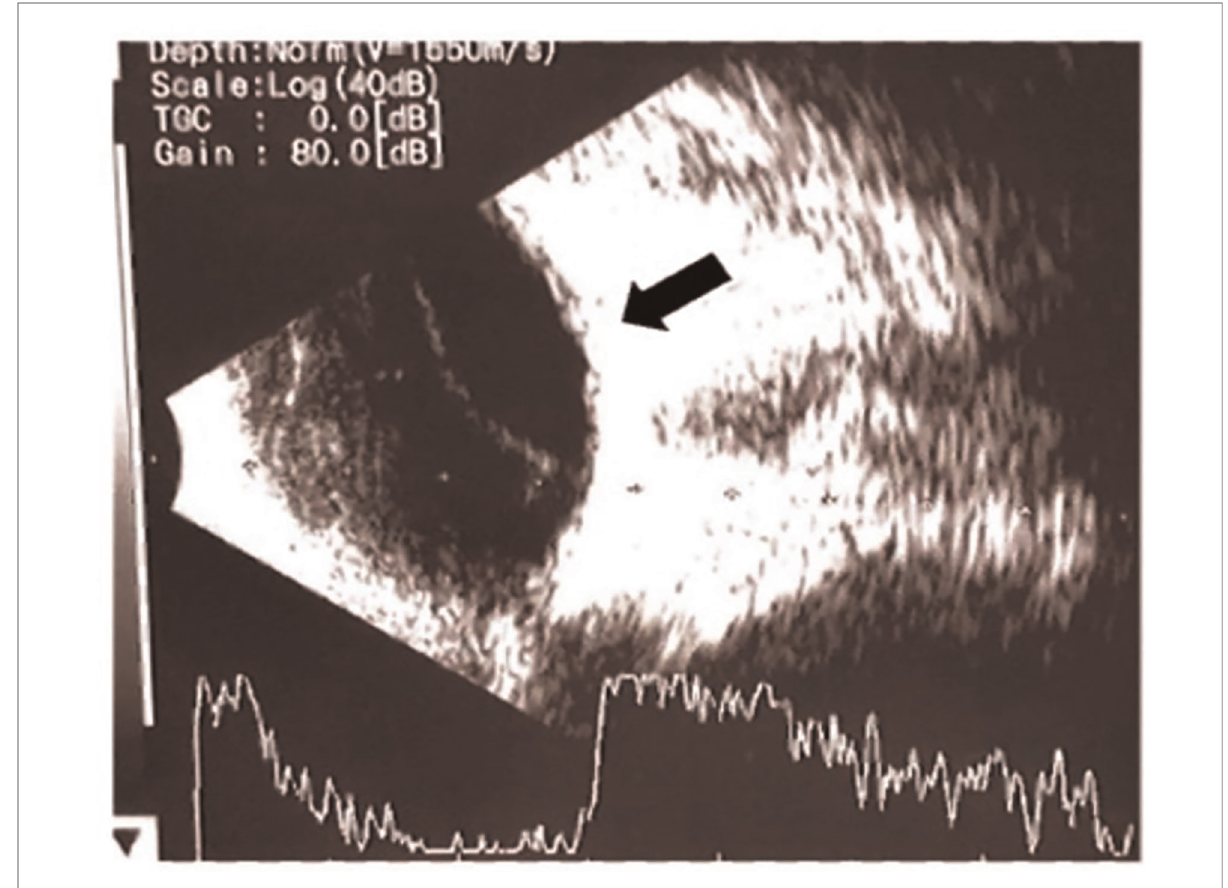
FIGURE 3 Ultrasound examination of the left eye showed pan-uveitis developed exudative retinal